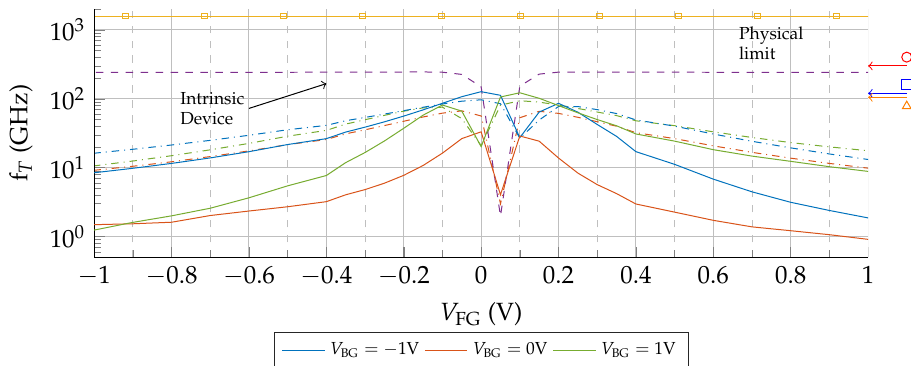
Figure 8. f T of the back-gated device with access regions under two scenarios: no puddles (solid lines) and N p = 10 12 cm − 2 (dash-dotted lines). The values obtained for the intrinsic device are depicted by the purple dashed line. The arrows labelled by marks on the right side axis indicate the values of f T extracted from [35] (circle) and [36] (square and triangle). The yellow line indicates the physical limit for graphene v F /2 π L , determined by the transit time L / v F , with the Fermi velocity v F ≈ 10 8 cm/s and L = 100 nm